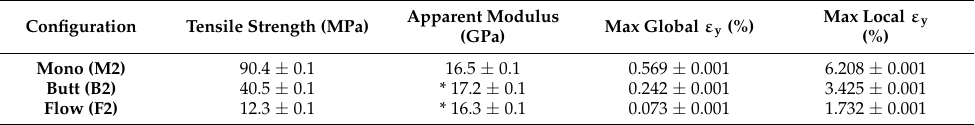
Figure 8. Comparing tensile coupons from the Mono plaque (M2, ( a , b )), Butt (B2, ( c , d )), Flow (F2, ( e , f )). ( a , c , e ) DIC measurement at σ Max ; ( b , d , f ) main EC fibre angles; ( g ) Comparing specimen strain distributions at σ Max . (For interpretation of the references to colour in this figure legend, the reader is referred to the web version of this article). The width of each test specimen and the image is 2.5 cm. Table 5. Mechanical properties of three specimen M2, B2, and F2 shown in Figure 8. * Please note that the modulus of the WL specimens was obtained from the “virtual” extensometer applied in the central gauge region in the DIC